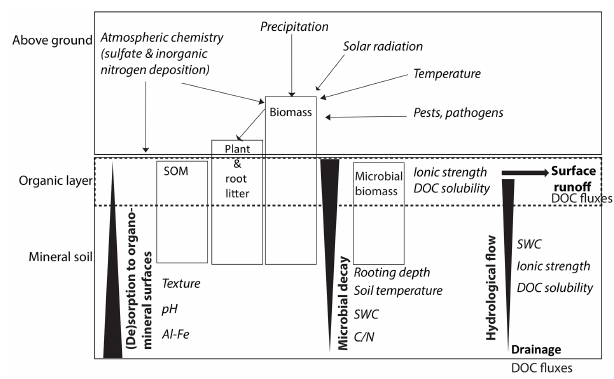
Figure 1. Schematic diagram illustrating the main sources (in boxes) of dissolved organic carbon (DOC) and the main processes (in bold) and factors (in italics) controlling DOC concentrations in